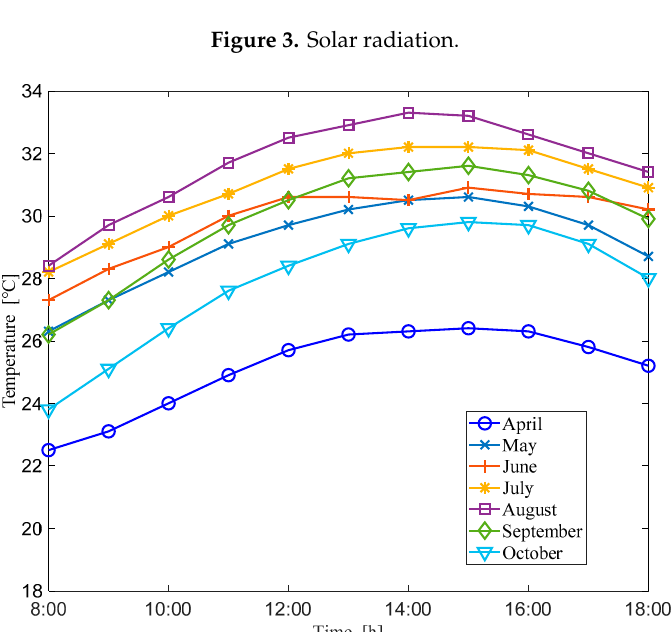
Figure 3. Solar radiation.